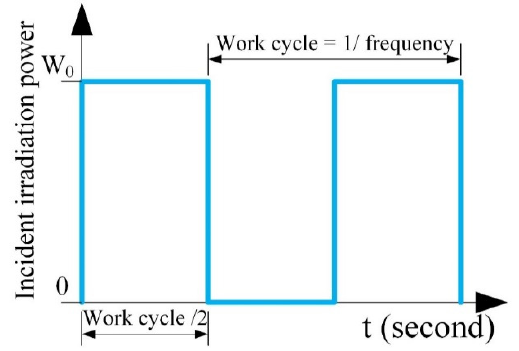
Figure 2. The incident radiation power with a work cycle applied to the PZT